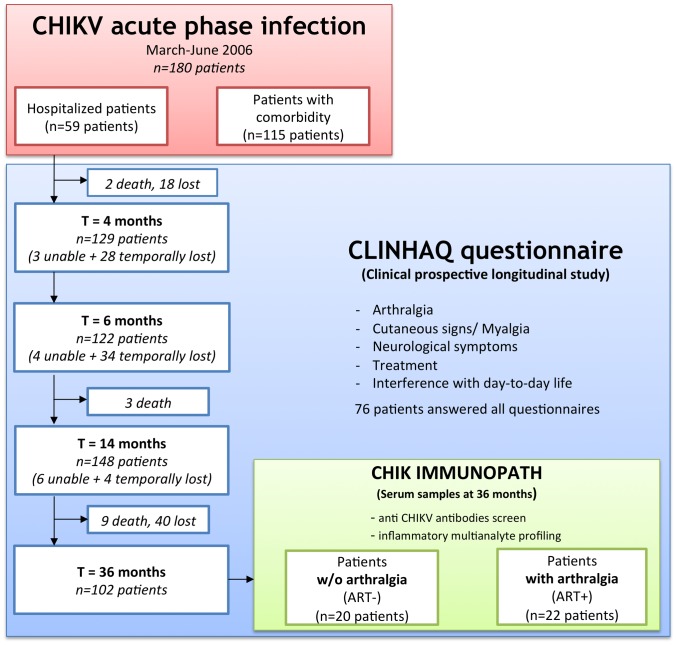
Diagram of the clinical study.“unable”: patients who were reached but unable to answer to the questionnaire, “lost”: patient lost of follow up until the end of the study, “temporally lost”: not reached at a specific timepoint, “death”: dead patients.